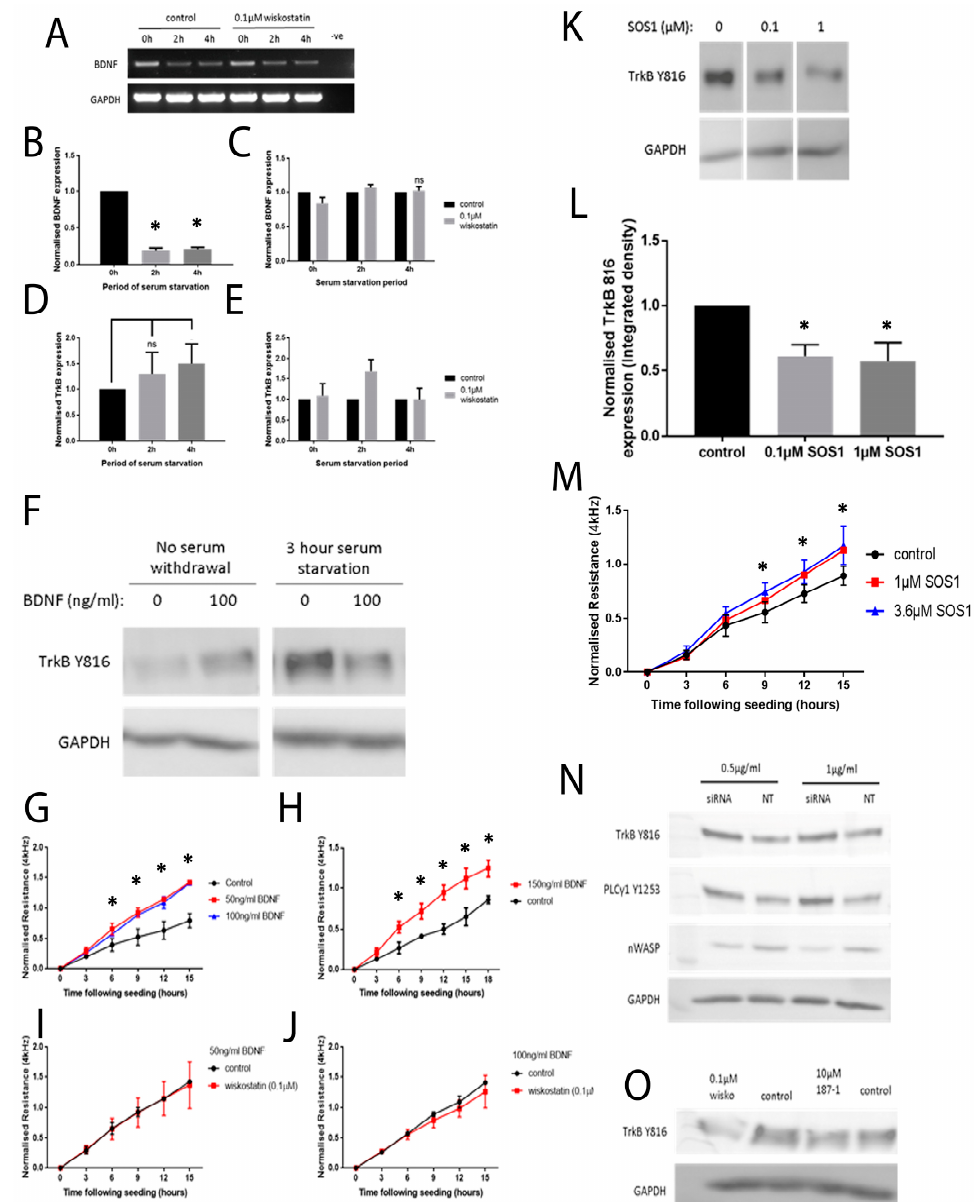
Figure 7. BDNF and TrkB transcript expression in the HaCaT cells and the effects of the BDNF, SOS1 and knockdown models. PCR/qPCR results for BDNF and TrkB expression in HaCaT cells treated with 0.1 µ M wiskostatin ( A , B ); wiskostatin-treated samples at each serum starvation time point ( C ). qPCR analysis results of the TrkB transcript expression ( D ) and controls ( E ). Western blot analysis of TrkB Y816 ( F ). HaCaT cells were treated with rhBDNF at 50 and 100 ng/mL ( G ) and 150 ng/mL ( H ). Cells treated with 50 or 100 ng/mL BDNF and 0.1 µ M wiskostatin ( I , J ). TrkB phosphorylation and SOS1 ( K ) and the integrated density ( L ). HaCaT cells treated with SOS1 ( M ). The effect of nWASP inhibition on TrkB Y816 phosphorylation ( N ). The effect of 0.1 µ M wiskostatin and 10 µ M 187-1 on TrkB Y816 phosphorylation ( O ). * indicates statistical significance ( p < 0.05). ns: not